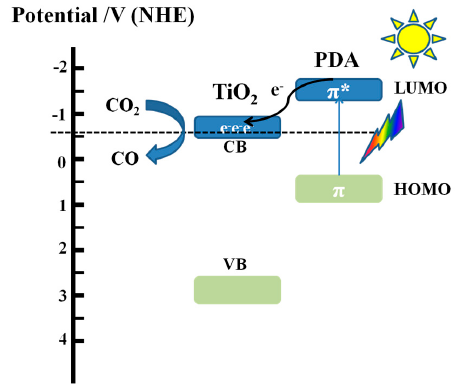
Figure 5. Illustration of the possible reaction mechanism for photoreduction of CO 2 with H 2 O under visible light over TiO 2 @PDA.